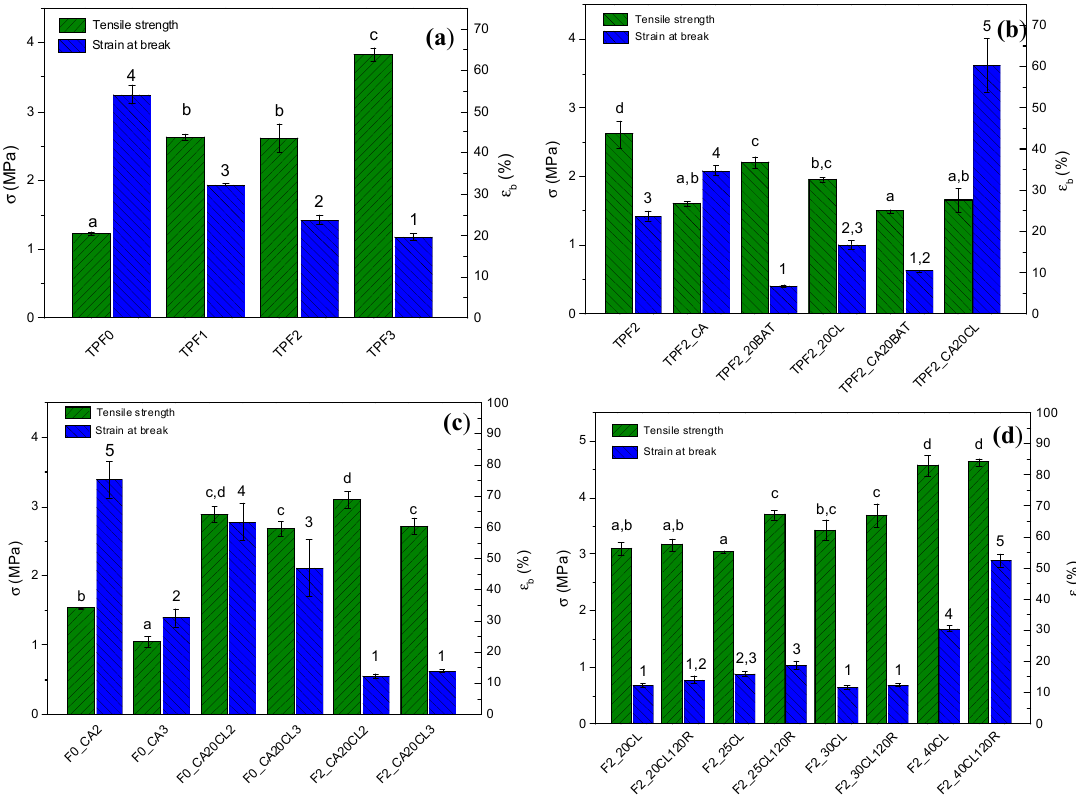
Figure 4. Results of tensile strength and strain at break for ( a ) TPWF/bran film samples, ( b ) TPWF/bran and biopolymeric blends, ( c ) samples processed with two different plasticization temperature profiles (T2, T3), ( d ) samples processed with two different mixing rates (30 rpm, 120 rpm). (a–d, stress values) (1–5, strain values) Different superscripts within the same column group (stress or strain values) indicate significant differences among formulations ( p < 0.05).